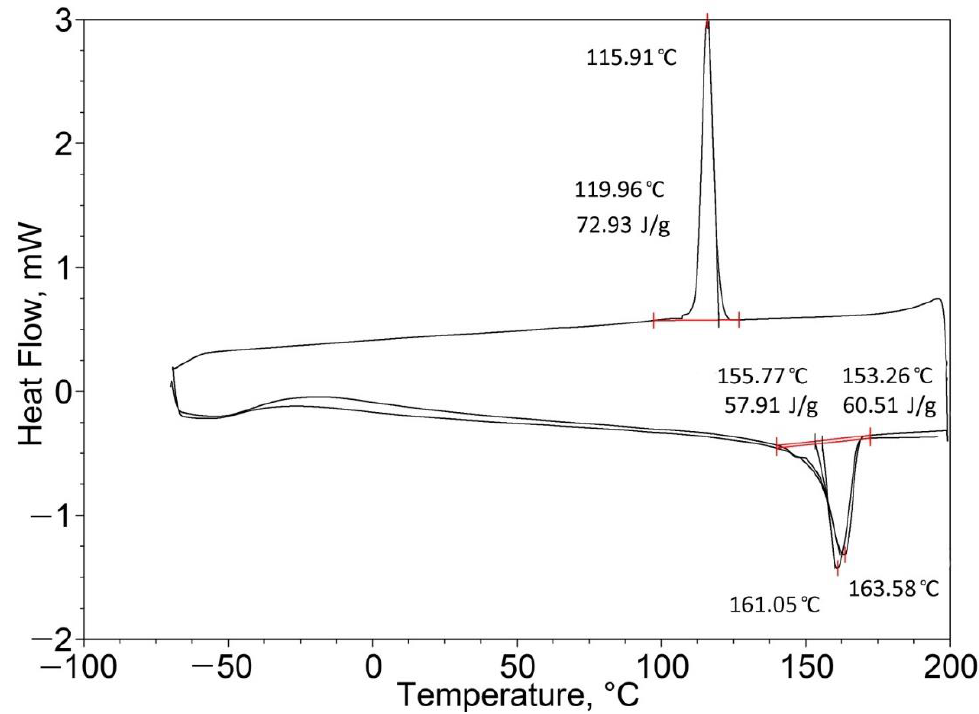
Figure 15. Melting-crystallization-melting diagram (DSC thermograms) of the 75% PP–25% EPTSR polymer blend produced by melt blending method.